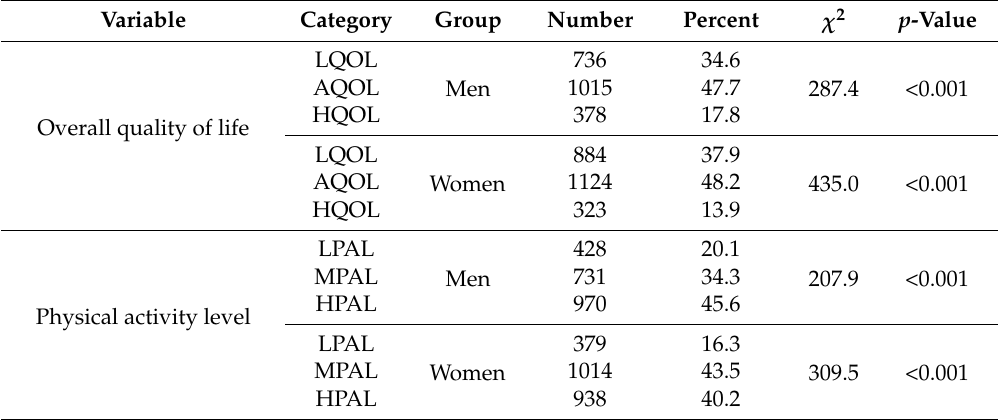
Table 1. Number and percentage of respondents in groups with different levels of overall quality of life and physical